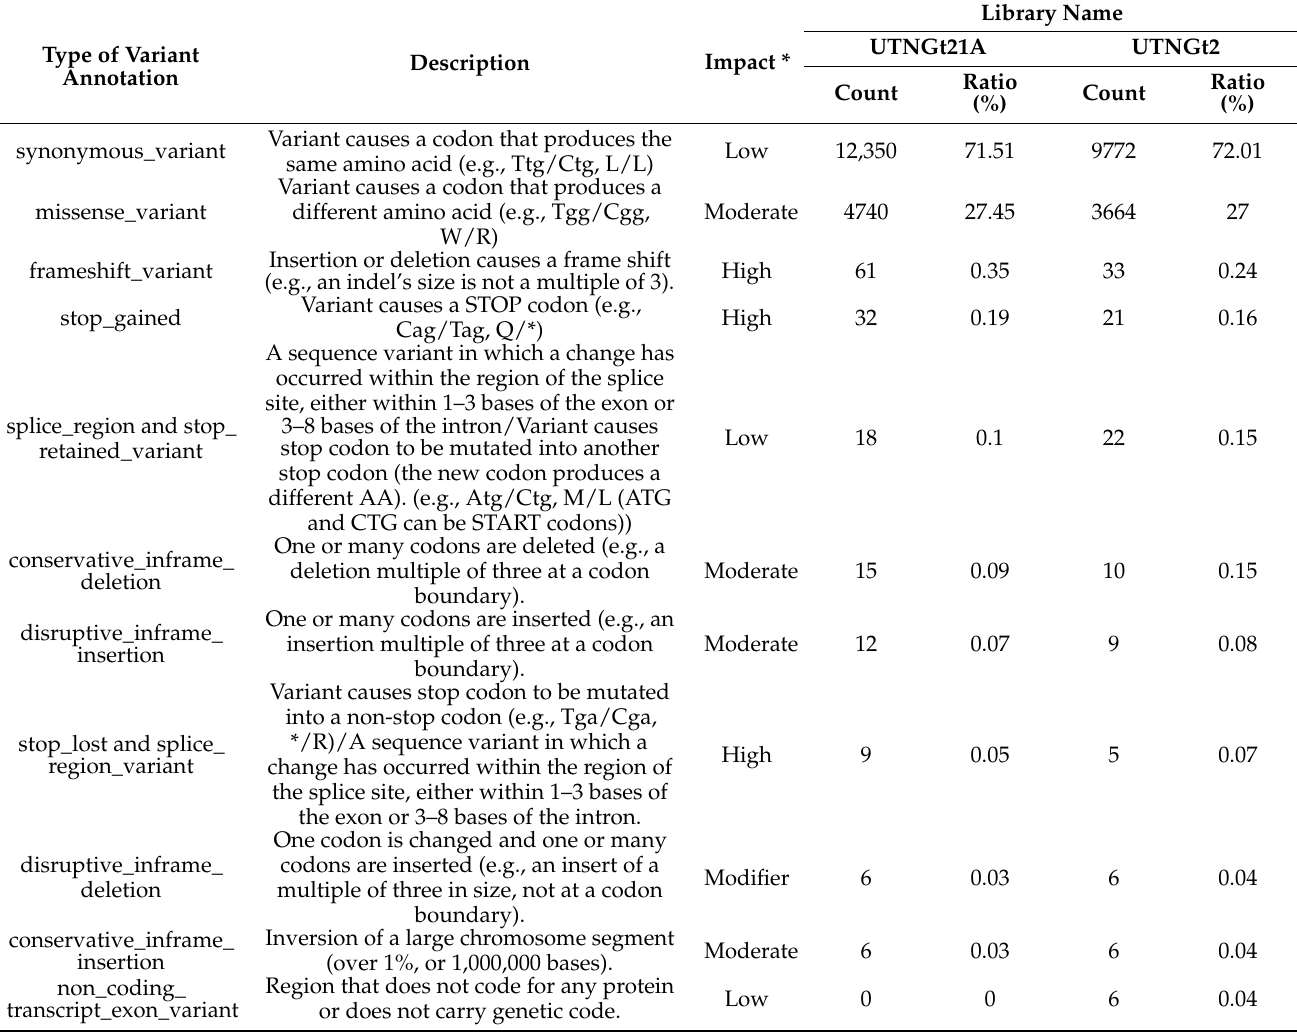
Table 2. Cumulative types of variant annotation, descriptions, and